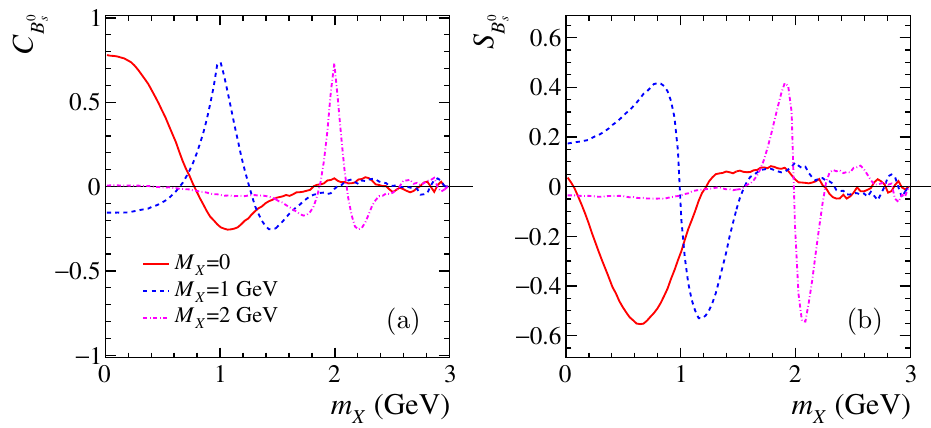
Figure 5 . (a) Real C and (b) imaginary S parts of the amplitude of the harmonic correspond- B 0 s B 0 s ing to B 0 oscillation frequency (cid:1) m s as a function of assigned mass m X for three values of the s